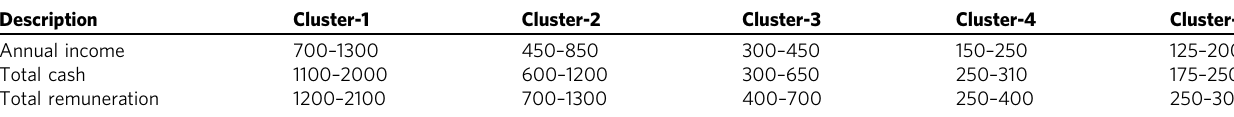
Table 2 Scale workers ’ bene fi t cement corporations (Rp million).